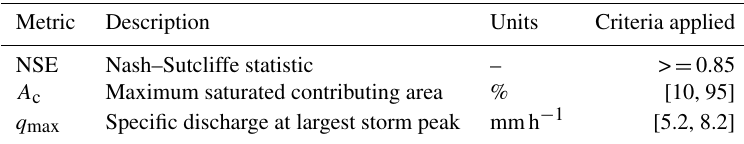
Figure 4. Simulated discharges across the storm period alongside rated observed discharges at Great Musgrave Bridge. The three named storms are indicated. Rainfall is interpolated between the gauges shown in Fig. 3. Table 2. Observables collected for each model realisation and acceptability criteria